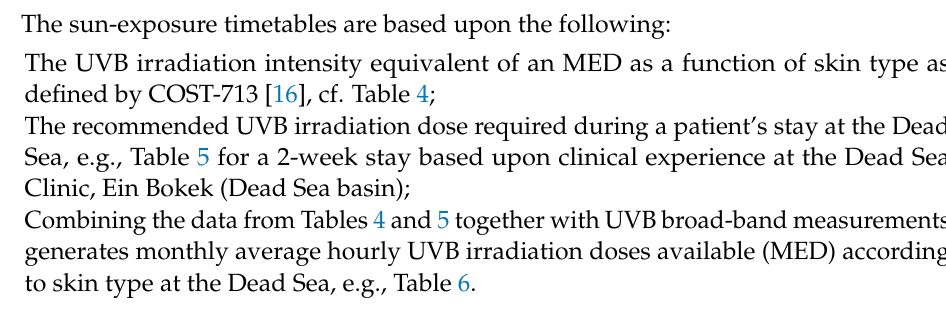
Figure 4. Ratio of 305.5:312.5 nm irradiation intensities at Neve Zohar during the July as a function of the time of day (Israel Standard Time = GMT +2).